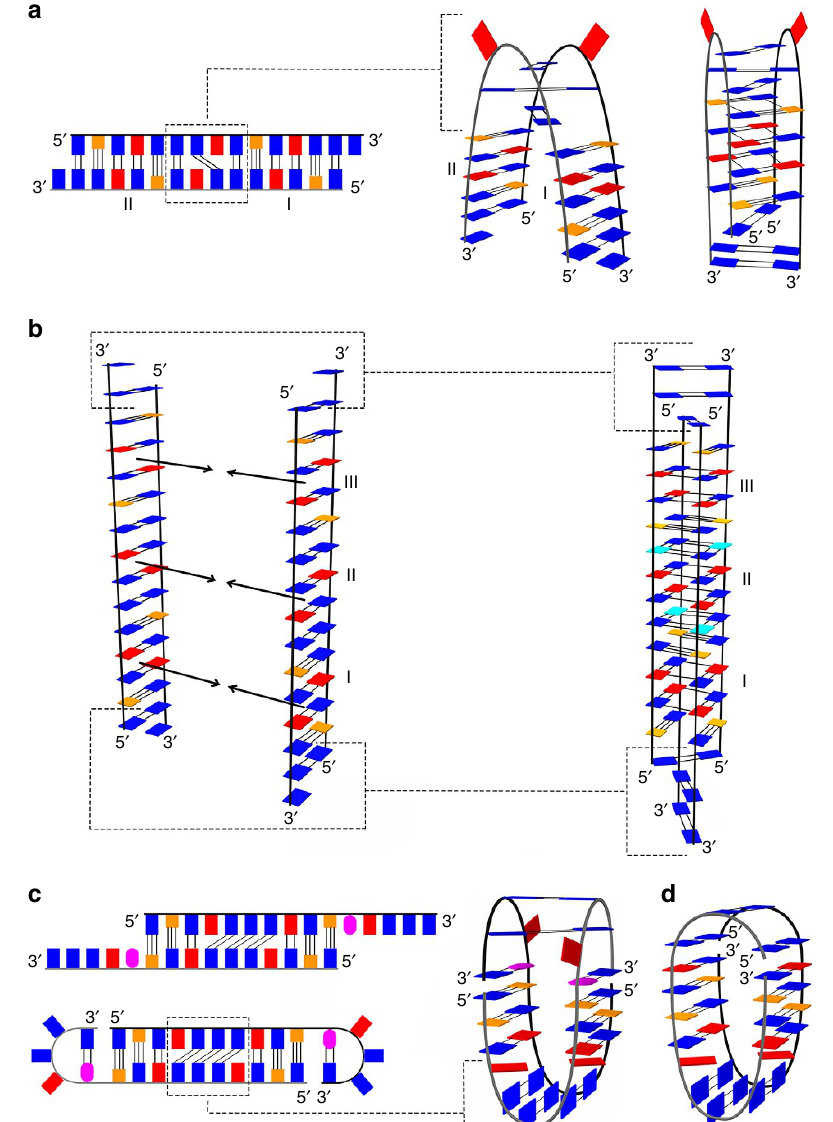
Figure 6 | Simplified folding model of oligonucleotides with AGCGA repeats separated by GGG tracts. ( a ) Folding model of the VK34 dimer. Roman numerals I and II indicate G-A base pairs that form the GAGA-core of the VK34 dimer. Completely folded VK34 dimer is shown on the right. ( b ) Folding model of the VK34 tetramer. The dashed lines show residues that form different base pairs in the VK34 tetramer than in the slipped duplex. Roman numerals I, II and III together with the arrows indicate G-A base pairs that associate into GAGA-quartets. ( c ) Folding model of VK34_I11. The dashed lines highlight different arrangements of two unpaired A4 residues separated by three G-G base pairs observed in a duplex compared with the VK34_I11 structure (right). ( d ) Topology of VK1. The guanine bases are shown in blue, guanines in syn conformation are indicated in cyan, inosine in magenta, adenine in red and cytosine in